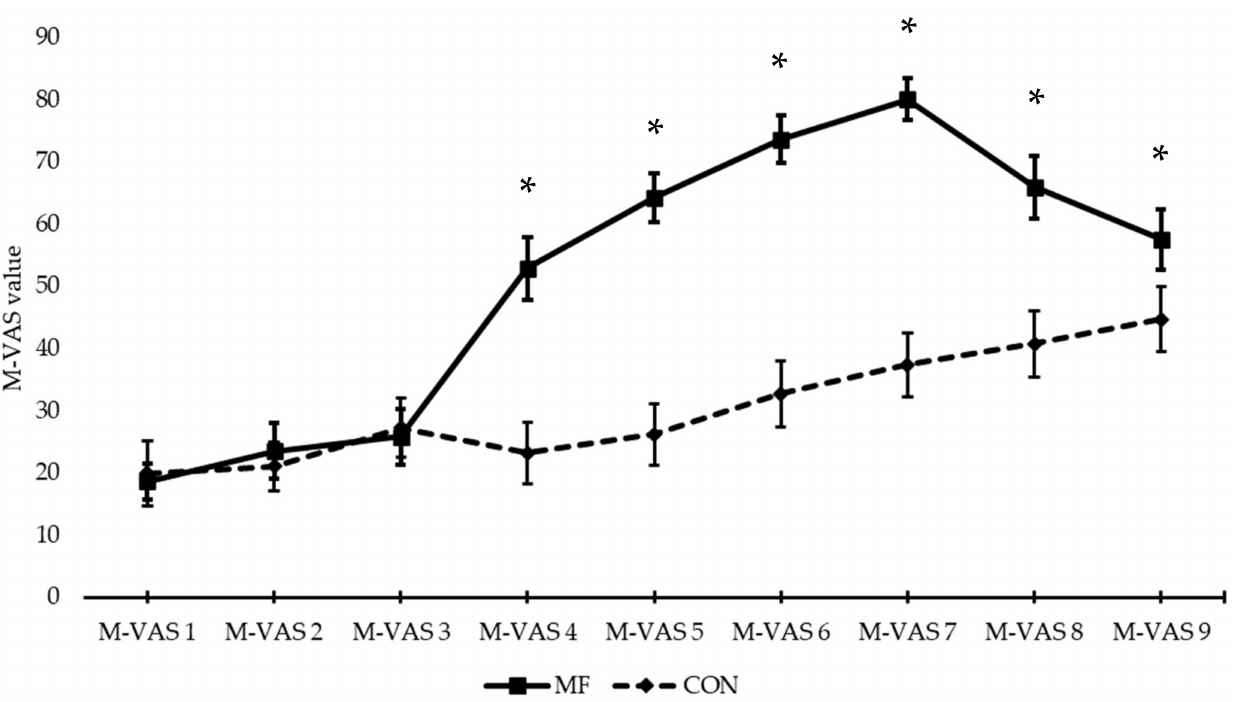
Figure 4. Graph of the M-VAS measurements across conditions (graph lines represent means ± SE;* = significant difference between the conditions). Table 4. M-Vas values across time point in both conditions with statistical comparison.